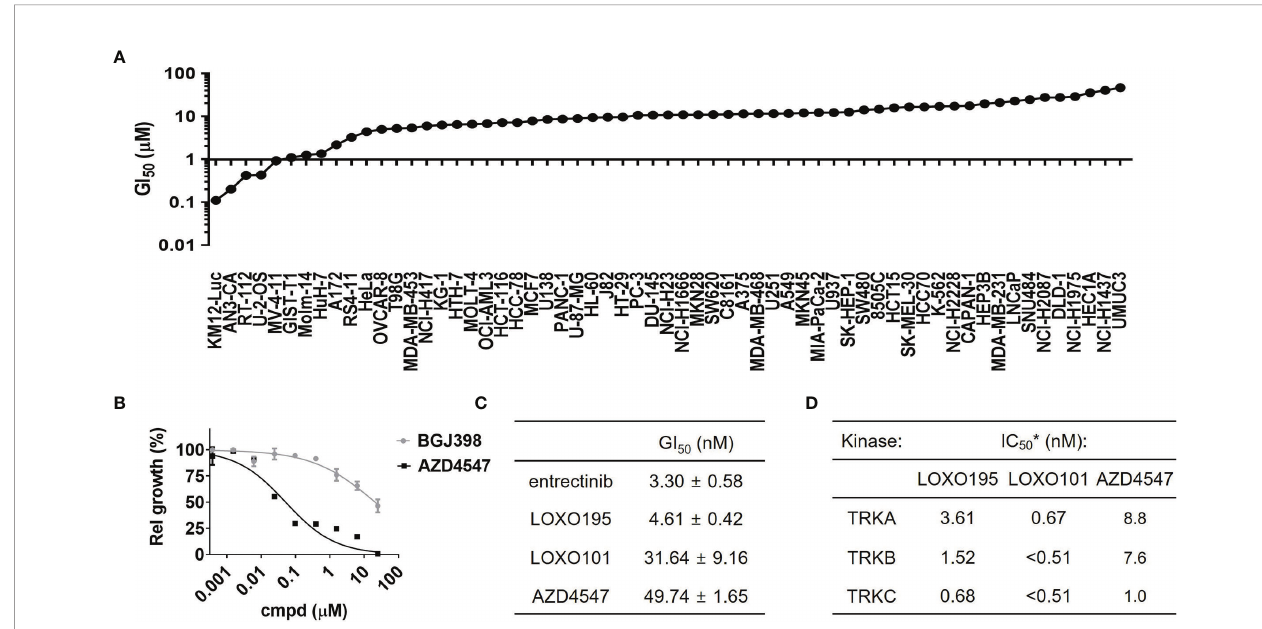
FIGURE 1 | AZD4547 is pan-TRK inhibitor. (A) Results of cancer cell screening of AZD4547 against 64 cancer cell lines. GI 50 of AZD4547 against 64 cancer cell lines are measured after 72 h incubation of serial diluted AZD4547. (B) Anti-proliferation activity of AZD4547 and BGJ398 on KM12(Luc). Cell viability of KM12(Luc) after 72 h exposure to AZD4547 or BGJ398 were determined by using a cell titer glo assay. (C) GI 50 values of TRK inhibitors and AZD4547 against KM12(Luc). GI 50 values were determined by using an MTT assay after 72 h exposure to the indicated substances. All experiments are duplicate mode and each GI 50 is an average of two independent assays. (D) IC 50 of AZD4547 against TRK isotypes. *Each of IC 50 was obtained by using a radiometric biochemical kinase